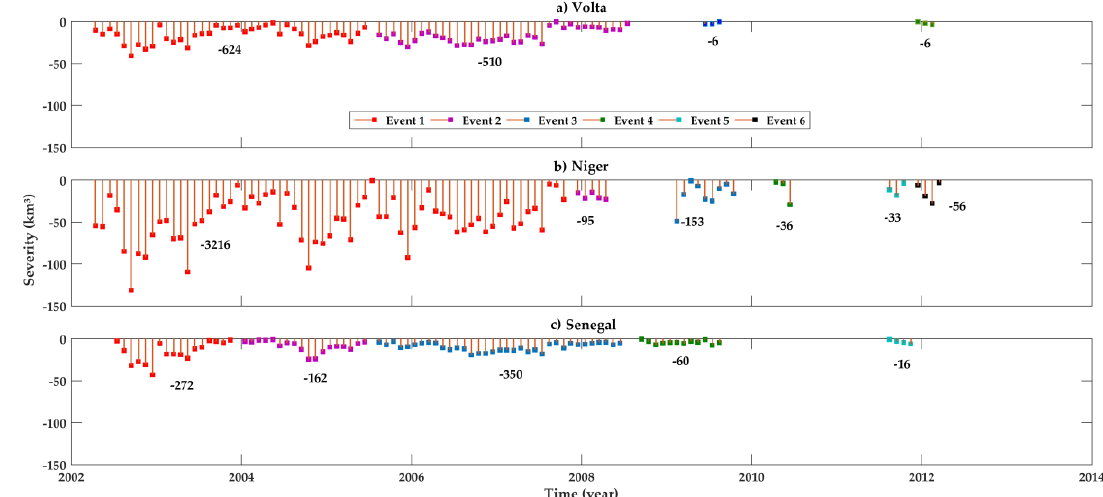
Figure 8. Instantaneous water storage deficits and severity for GRACE-observed, regional-average over ( a ) the Volta Basin, ( b ) Senegal Basin, and ( c ) Niger Basin. Total severity ( S ) values for each hydrological drought event are given in bold (mm/month).